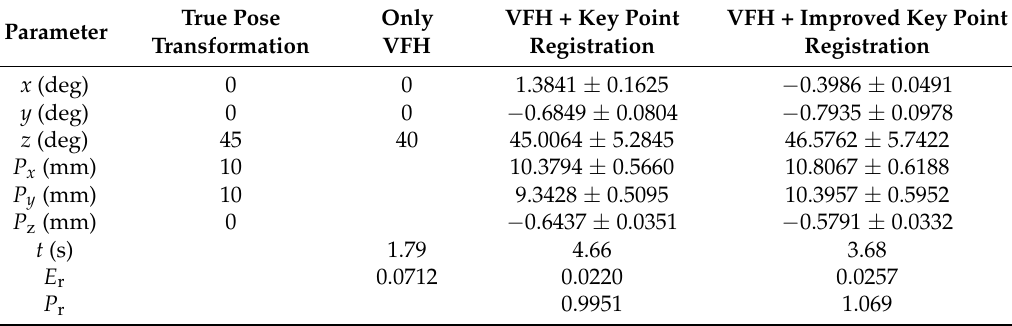
Table 2. Experiment results when nine templates are used.